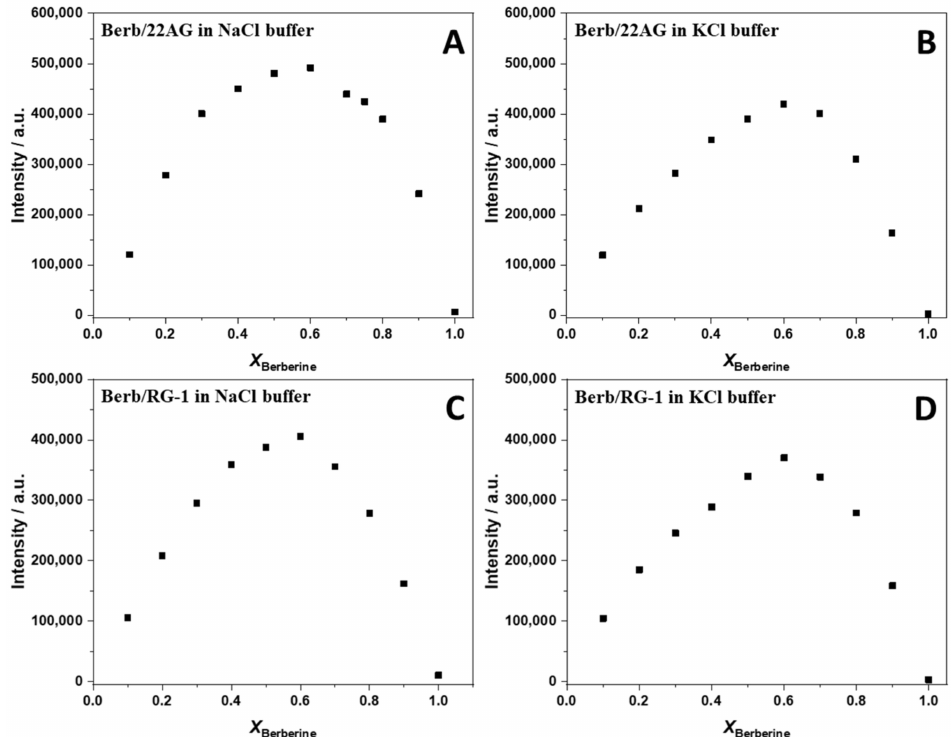
Figure 3. Job’s plot for the Berb/22AG (panel ( A , B )) and Berb/RG-1 (panel ( C , D )) systems obtained from fluorescence spectroscopy in 30 mM Tris buffer, pH 7.4, with the addition of 100 mM NaCl or KCl. The total concentrations ((Berb) + (G4Qs)) were 80 µ M, 60 µ M, 60 µ M, and 50 µ M for the experiments shown in panel ( A – D ), respectively. The excitation wavelength was set at 443 nm. The fluorescence intensity was recorded at the maximum of emission (536 nm). All the experiments were carried out at 25 ◦ C and ambient